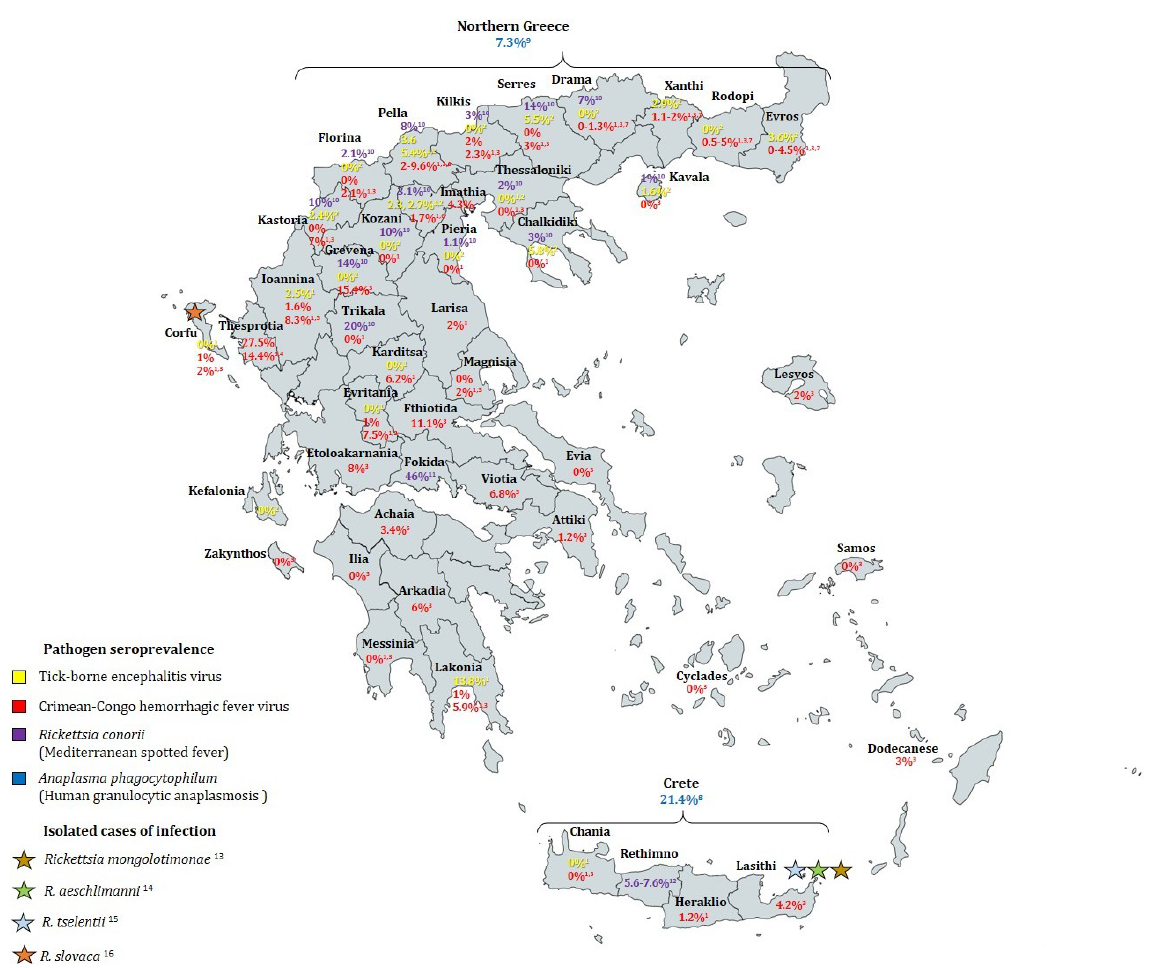
Figure 1. Map of the reported seroprevalence rates and isolated cases of human tick-borne diseases in different regional units of Greece, as described in the literature. 1 [47], 2 [48], 3 [52], 4 [53], 5 [55], 6 [62], 7 [54], 8 [76], 9 [77], 10 [68], 11 [66], 12 [67], 13